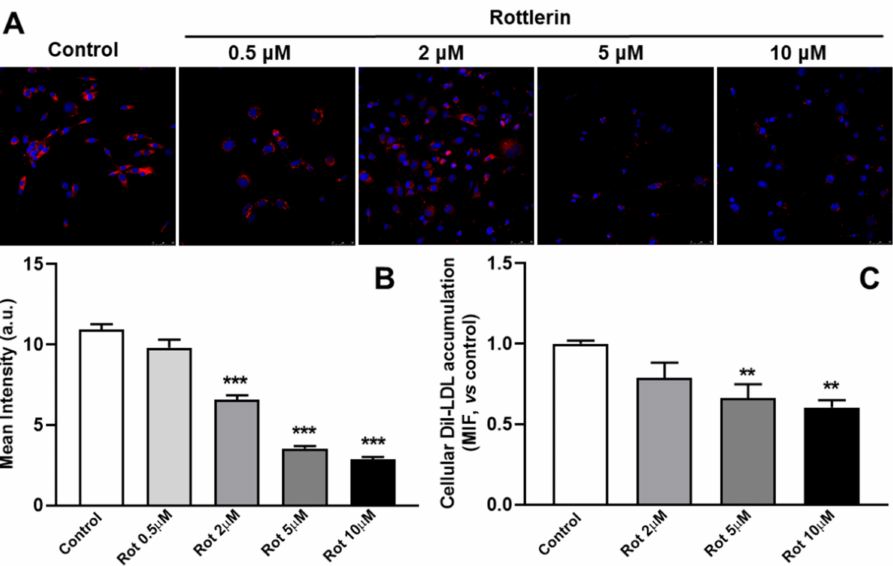
Figure 1. Effects of rottlerin on the intracellular distribution of LDL in cells treated with U18666A. ( A ) C6 cells were exposed to DiI-LDL (20 µ g/mL of cholesterol) and 2.5 µ M U18666A for a total of 16 h without (control) or with rottlerin (0.5 µ M, 2 µ M, 5 µ M, and 10 µ M) for the last 4 h. The cells were then washed, fixed and analyzed by confocal microscopy. Images show DiI-LDL in red and nuclei labeled with Hoechst-33342 in blue. Representative results from three independent experiments are shown. Scale bars = 25 µ m. ( B ) The graph shows the results of the quantification of DiI-LDL (mean intensity, a.u.) of cells of each photomicrograph. Results are the mean ± SEM of three independent experiments, with 8 − 10 photographs per experiment. ( C ) The graph represents the intracellular DiI-LDL fluorescence in C6 cells exposed to DiI-LDL (20 µ g/mL of cholesterol) and U18666A (2.5 µ M) for a total of 16 h with or without (Control) treatment with rottlerin (2 µ M, 5 µ M, and 10 µ M) for the last 4 h, by flow cytometry. The control is normalized to 1. Results are the mean ± SEM of three independent experiments. Rot, rottlerin. Statistical comparisons shown are rottlerin versus control (** p < 0.01, *** p <